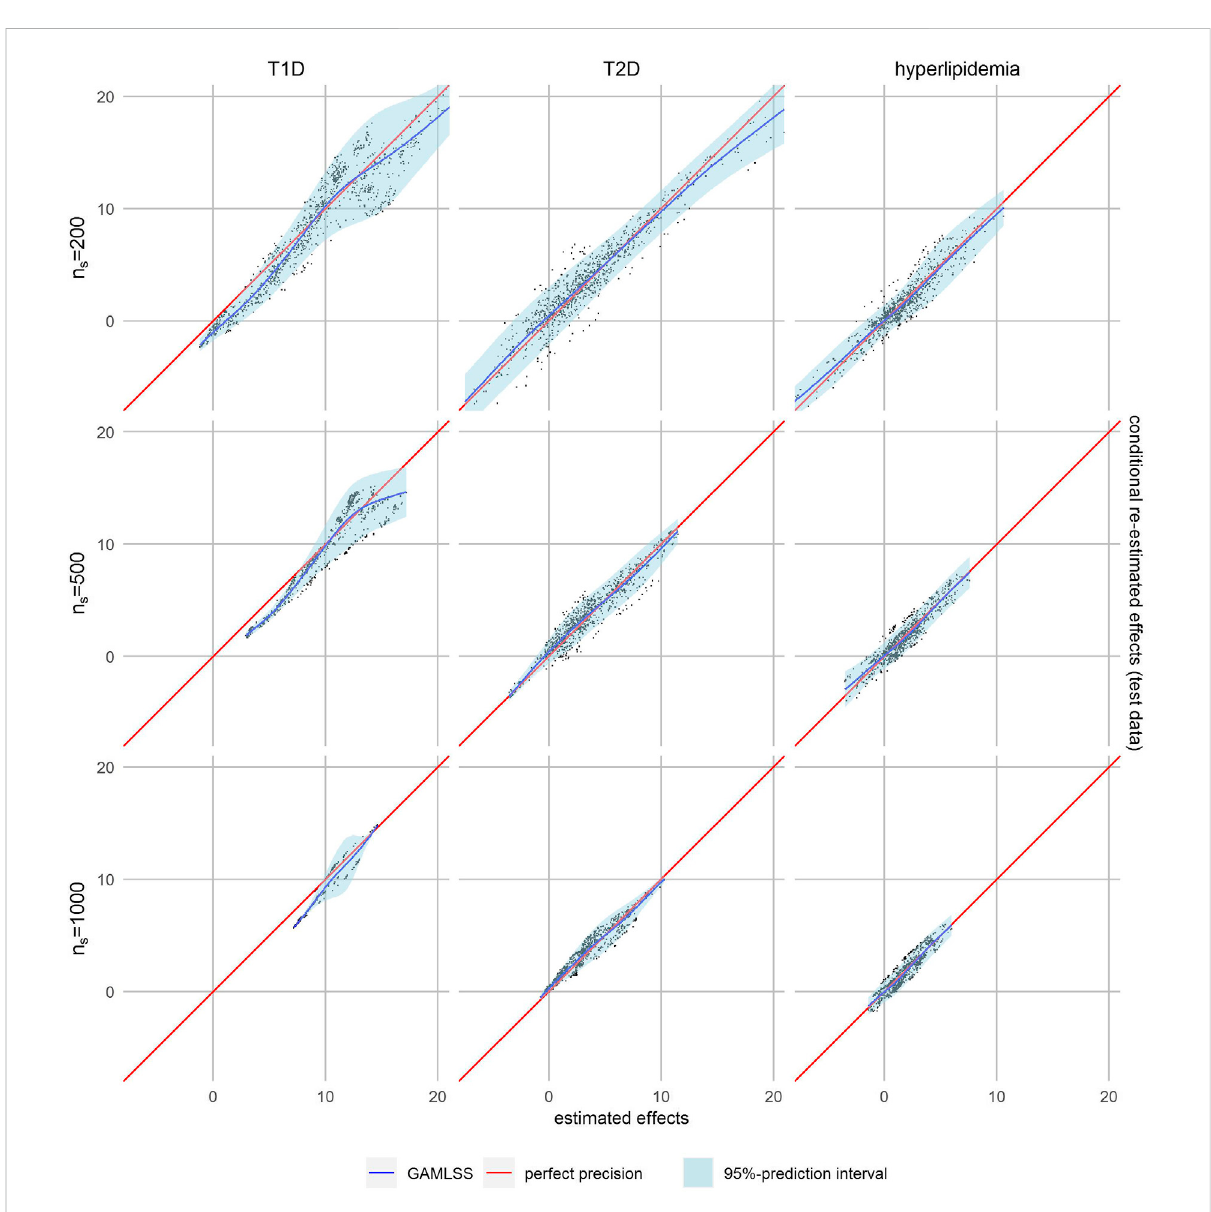
FIGURE 2 Calibration plots with non-linear fi t (blue line) and 95% prediction interval (light blue